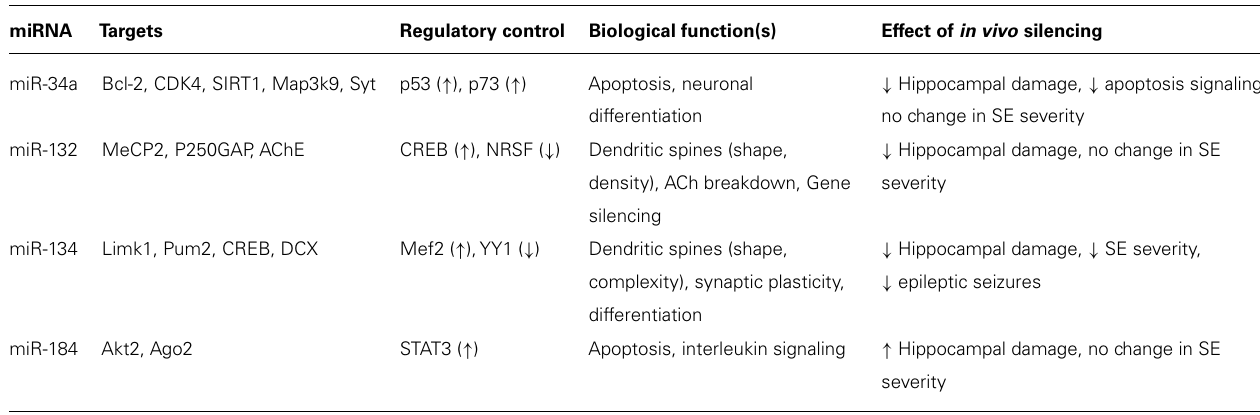
Table 2 | miRNAs targeted in status